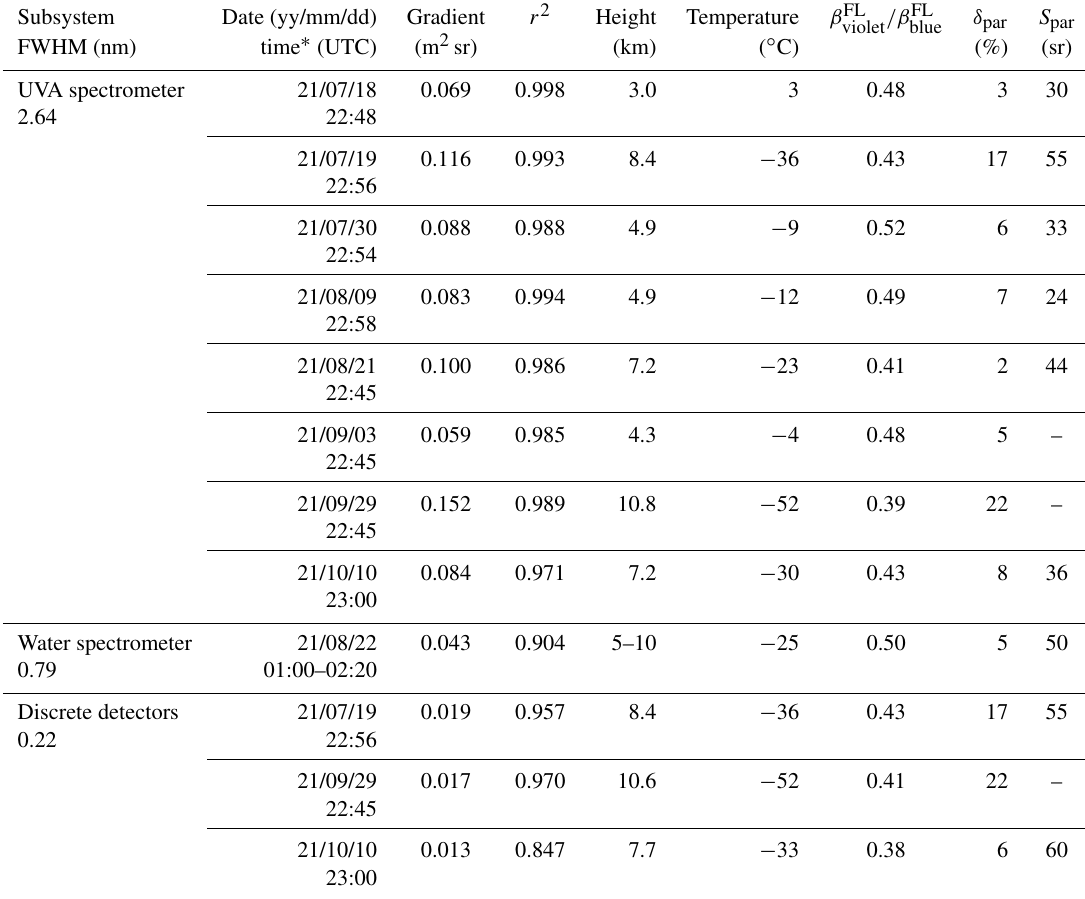
Table 1. Summary of humidity measurements in BBA layers.